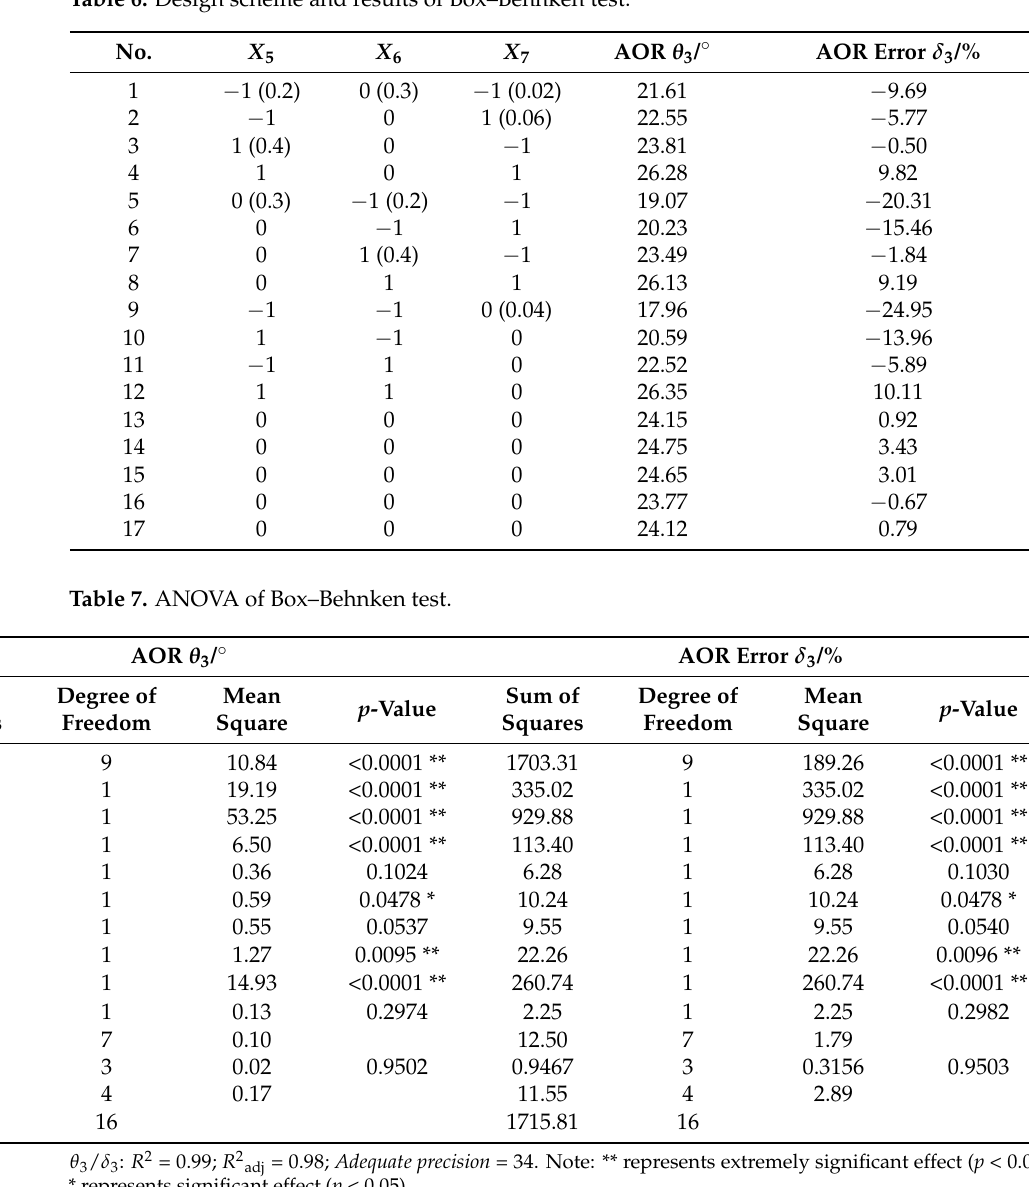
Table 6. Design scheme and results of Box–Behnken test.